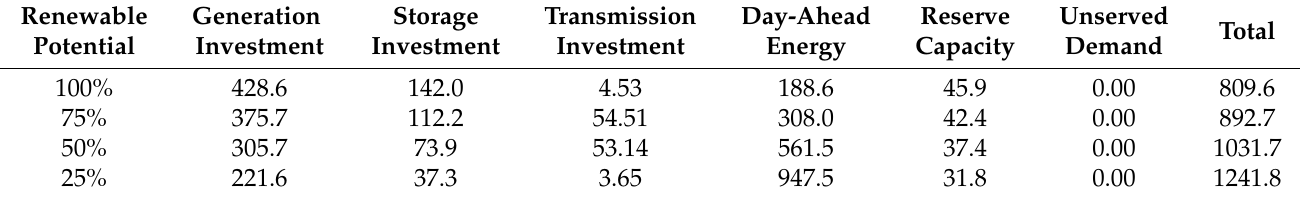
Table 19. Expected cost as a function of the renewable potentials (million e ).